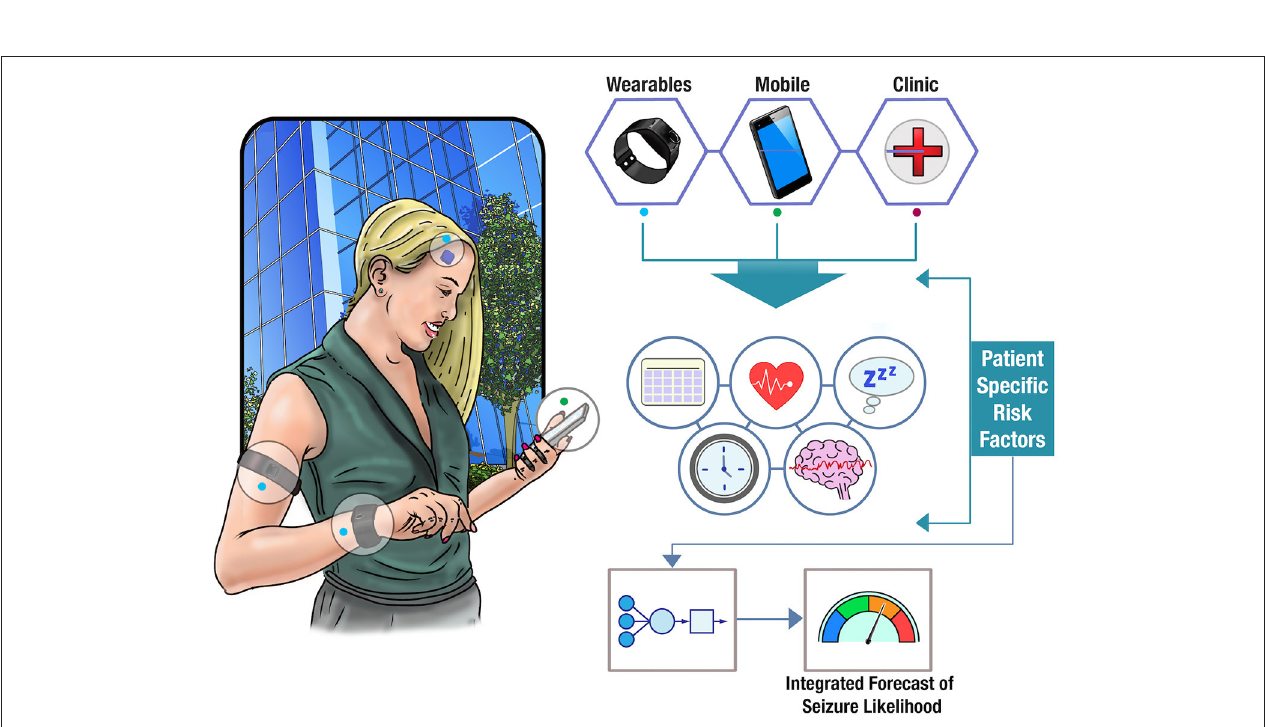
FIGURE 3 | Forecasting seizure likelihood. The schematic shows how data from clinical notes, wearable devices, and mobile apps can be combined to obtain a deeper understanding of patient-specific risk factors. Utilizing cloud computing, these factors can be integrated into an individualized model of seizure likelihood and displayed as a real-time forecast to a